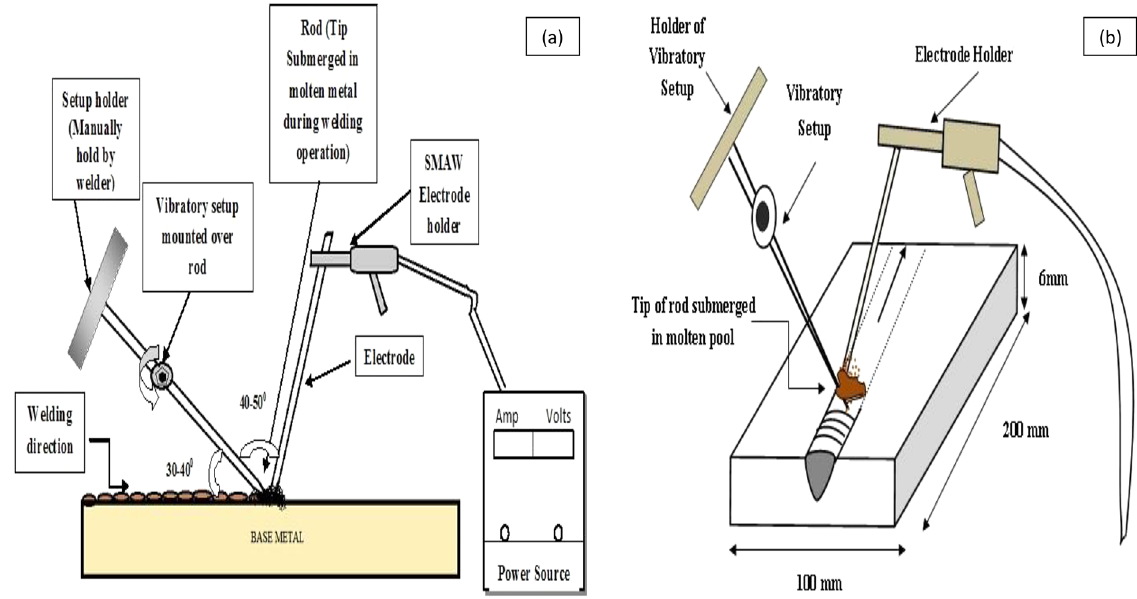
Fig. 1. (a) Schematic block diagram of vibratory setup presenting the angles and positions of vibratory setup. (b) Top view diagram of vibratory